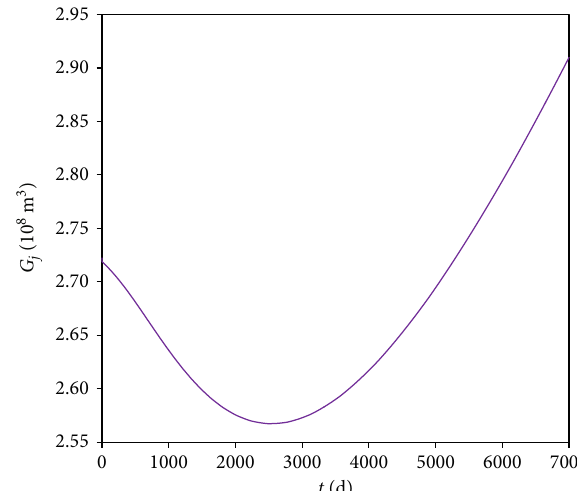
Figure 25: The estimated pro fi le of G